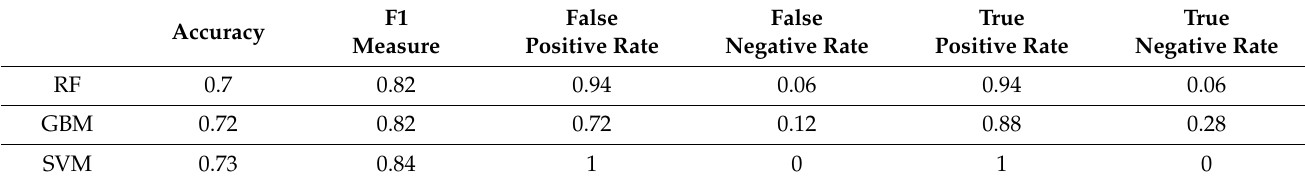
Table 2. Performance of the classification algorithms, obtained using scaled spectral data as input.